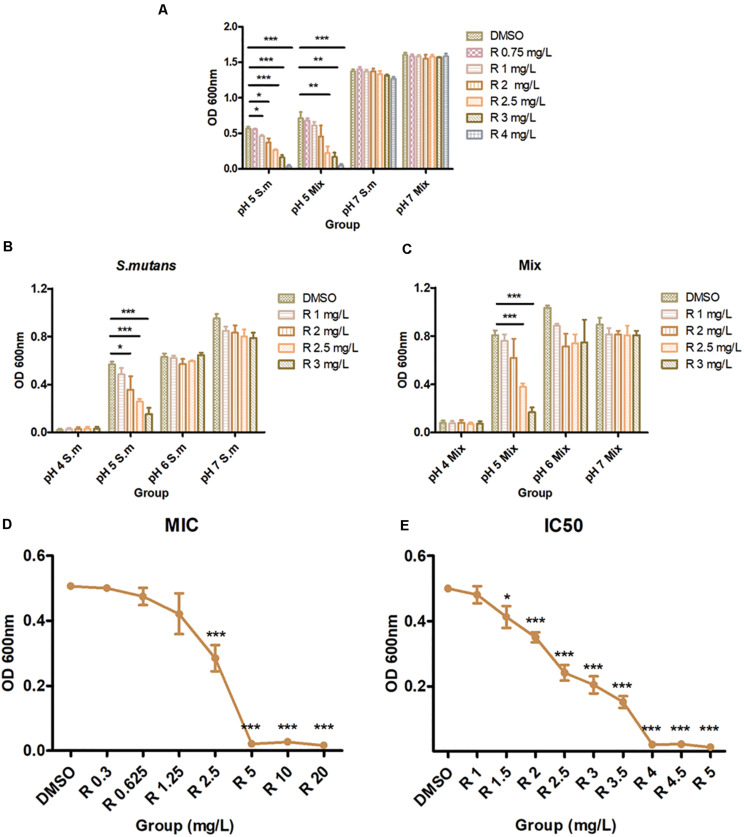
Antibacterial properties of bedaquiline treatment. (A) In pH 5 and 7 BHI, the antibacterial effect of 0.75–4 mg/L of bedaquiline and DMSO against planktonic S. mutans and Mix (S. mutans, S. sanguinis, and S. salivarius). (B) In pH 4–7 BHI, the antibacterial effect of 1–3 mg/L of bedaquiline and DMSO against planktonic S. mutans. (C) In pH 4–7 BHI, the antibacterial effect of 1–3 mg/L of bedaquiline and DMSO against planktonic Mix. (D) The MIC assay of bedaquiline against planktonic S. mutans in pH 5 BHI. (E) The IC50 assay of bedaquiline against planktonic S. mutans in pH 5 BHI. *, **, and *** indicate statistically significant differences at p < 0.05, p < 0.01, and p < 0.001, respectively. Error bars are standard deviations.